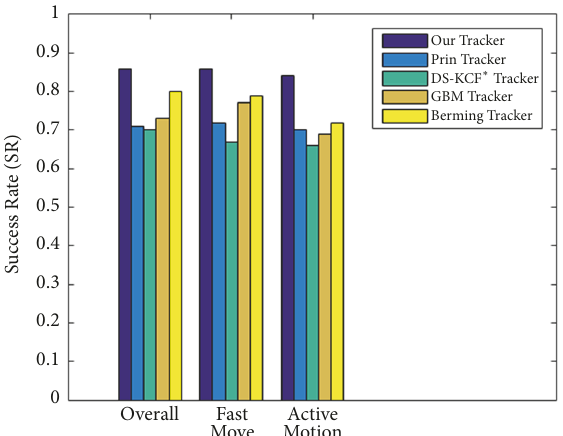
Figure 5: The comparison results of SR on the PTB dataset.